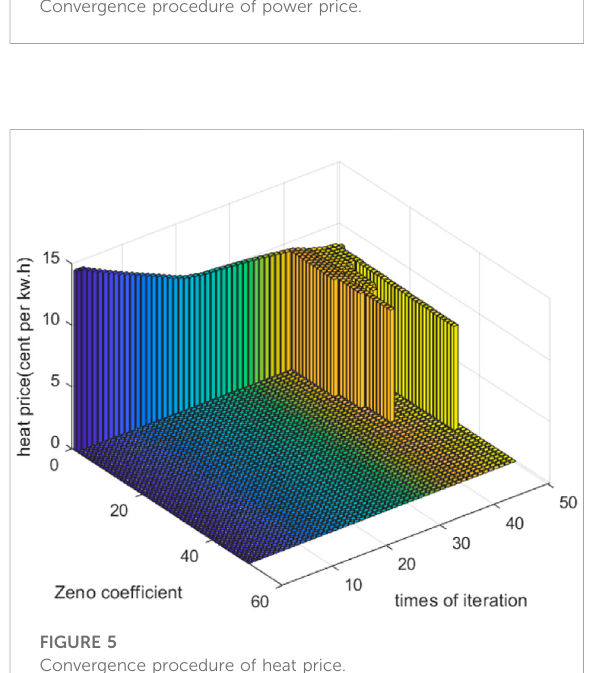
FIGURE 4 Convergence procedure of power price.